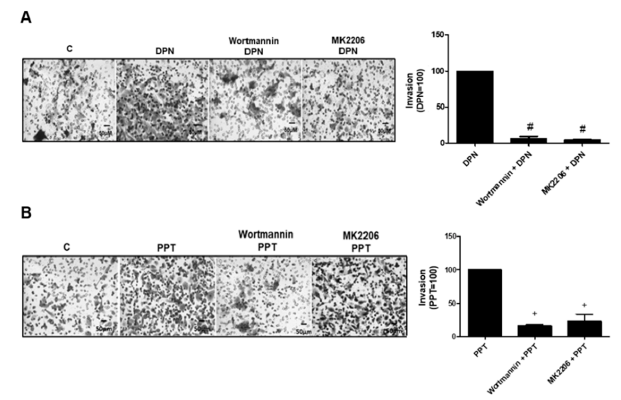
Figure 7. Effects of the PI3K specific inhibitor (Wortmannin) and AKT inhibitor (MK2206) on the invasion of androgen-independent prostate cancer cells PC-3 induced by DPN and PPT. Cells were incubated in the absence (C, control) and presence of DPN (10 nM) ( A ) or PPT (10 nM) ( B ) for 48 h at 37 °C. The cells were pre-treated with Wortmannin (1 µM) or MK2206 (200 nM) for 30 min, and then incubated or not with DPN ( A ) or PPT ( B ) for 48 h. Representative image of PC-3 cell invasion. The membranes containing the invaded cells (under the surface of membrane), were photographed. Images of three random microscope fields, in duplicate, were captured using an inverted optical microscope. The areas of invaded cells were determined by Image J software. Results were plotted (mean ± SEM) in relation to DPN or PPT and subtracted from the control (DPN = 100) ( A ) or PPT = 100) ( B ). # Significantly different from DPN ( p < 0.05, ANOVA and Newman-Keuls). + Significantly different from PPT ( p < 0.05, ANOVA and Newman-Keuls). Images are representative of three different experiments.